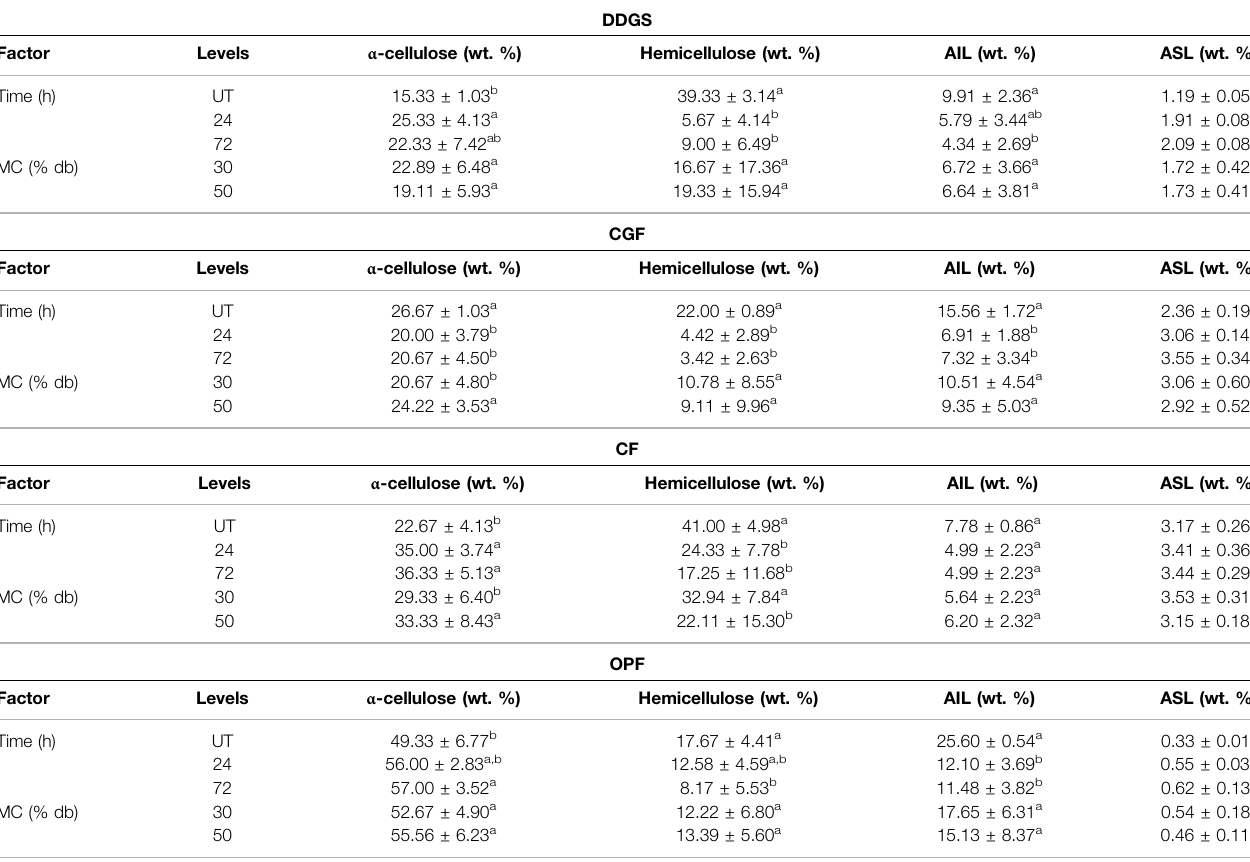
TABLE 3 | Main effects of factors on biomass compositions after LMAA pretreatment. a, b, c these signify signi fi cant